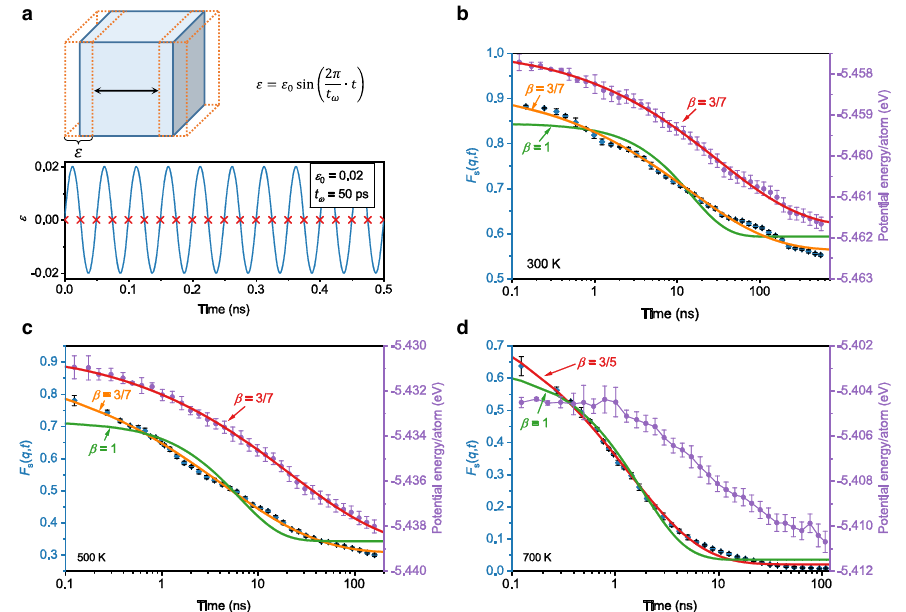
Fig. 1 | Vibration-accelerated aging and distinct relaxation dynamics. a Schematic of the simulation procedures of vibration-accelerated aging. A sinu- soidal tension-compression strain was applied along one direction with maximum strain of0.02 and period of50ps.The potential energy and structuralinformation were monitored when strain equals 0 (marked by red crosses). Self-intermediate